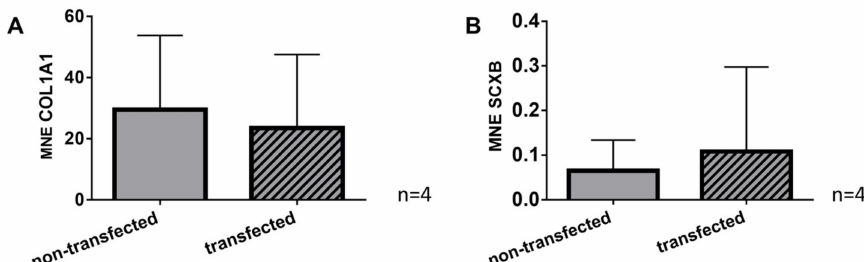
Figure 7. Gene expression profile of ligament ECM components in 2D cultured non-transfected and SV40 transfected ACL ligamentocytes. Gene expression of collagen type I (COL1A1) ( A ) and scleraxis (SCXB) ( B ). MNE: Mean normalized expression. Four independent experiments were performed. 2.8. Survival of Non-Transfected and SV40 Transfected Ligamentocytes in 3D Culture By using the hanging drop method (50,000 and 150,000 cells per spheroid) SV40 transfected cells produced only instable spheroids compared to the control ligamentocytes of the same donor. In addition, SV40 transfected cells died on the sca ff olds after 21–28 d independent of the spheroid size of 50,000 [Figures 8 and 9] or of 150,000 [not shown] cells per spheroid in 3D sca ff old culture. The non-transfected cells, however, survived until the end of the observation period of five weeks.